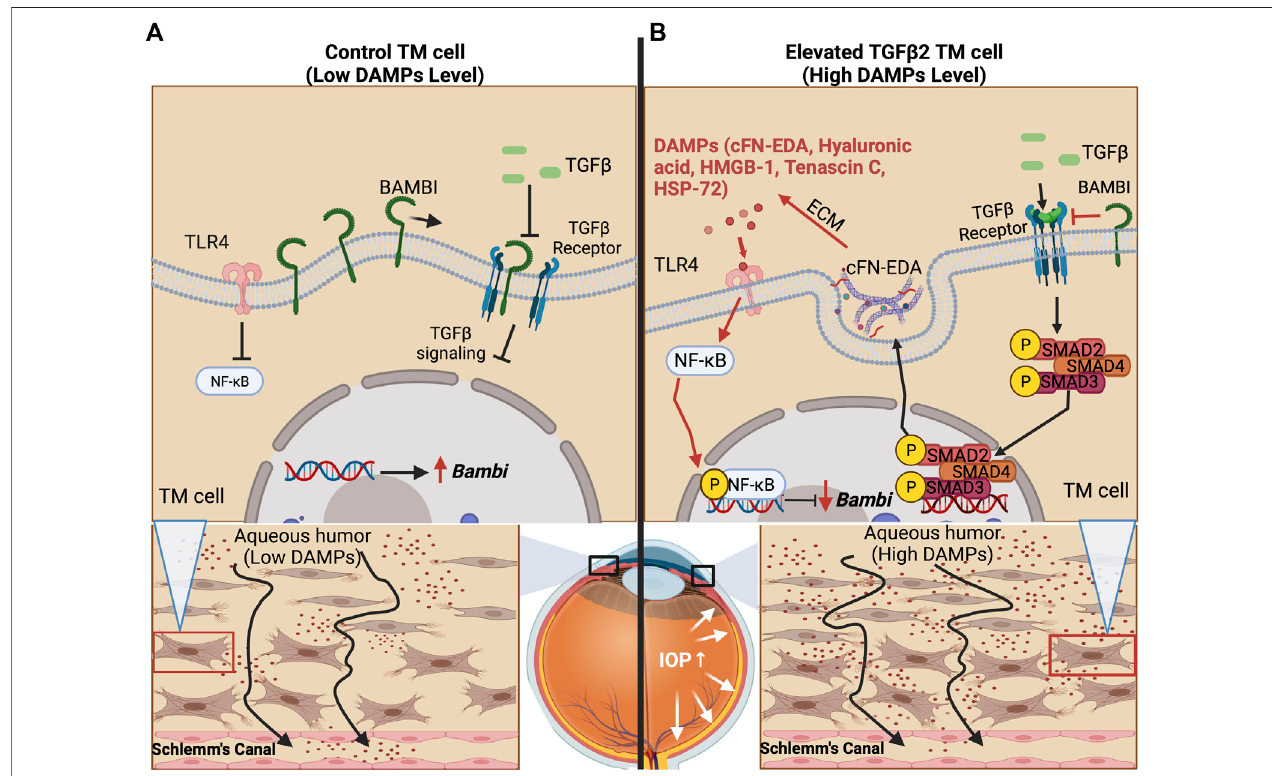
FIGURE2| TLR4andTGF β 2signalingcrosstalk. (A) ThetrabecularmeshworkunderhomeostasisexpressesbasallevelsofextracellularmatrixproteinsandBMP and Activin Membrane Bound Inhibitor (BAMBI), which inhibits endogenous TGF β 2 signaling. (B) Bioactivated TGF β 2 leads tothe expression of DAMPs, including cFN- EDA and LMW Hyaluronic acid, which activate TLR4 and lead to subsequent NF- κ B activation. Phosphorylated NF- κ B lowers the expression of BAMBI, which in turn, leads to uninhibited TGF β 2 signaling.